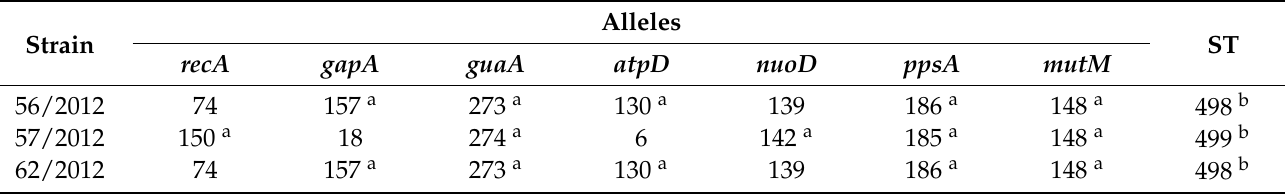
Table 4. Alleles and sequence types in S. maltophilia